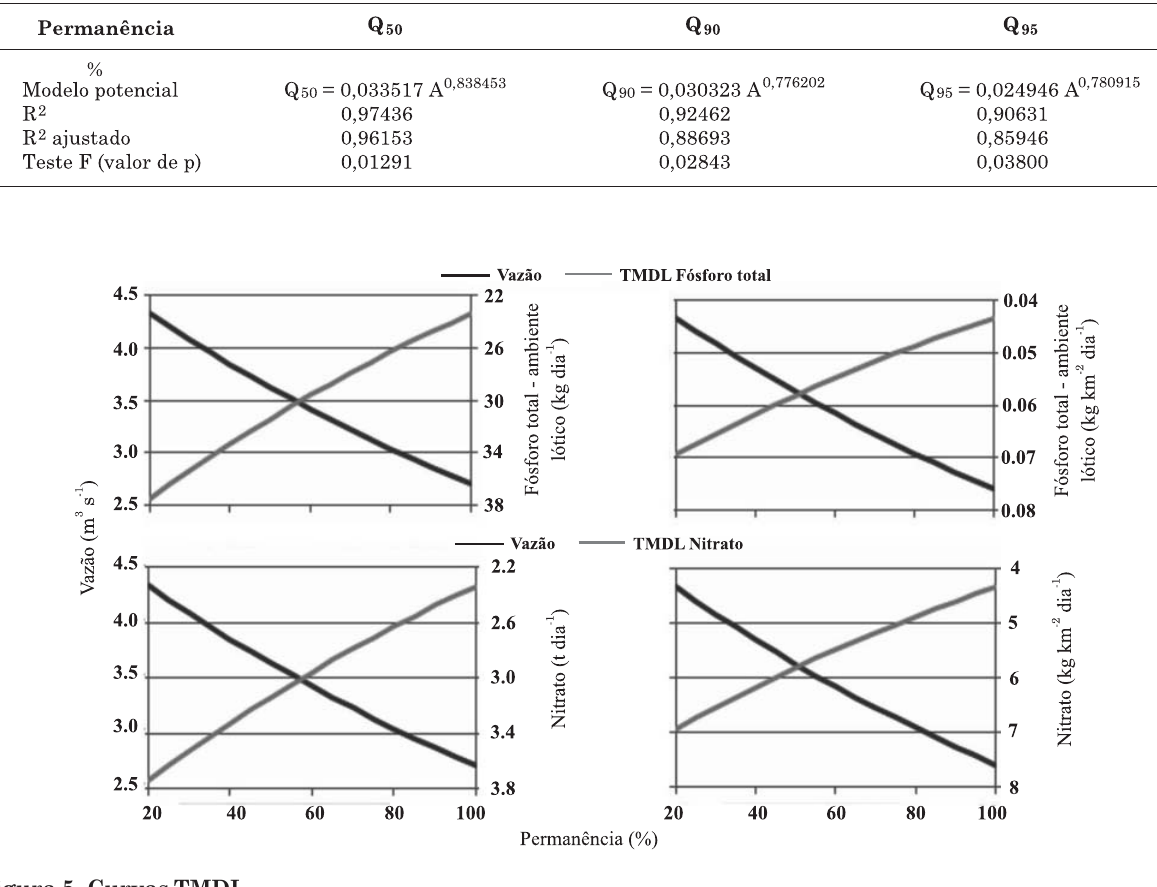
Figura 5. Curvas